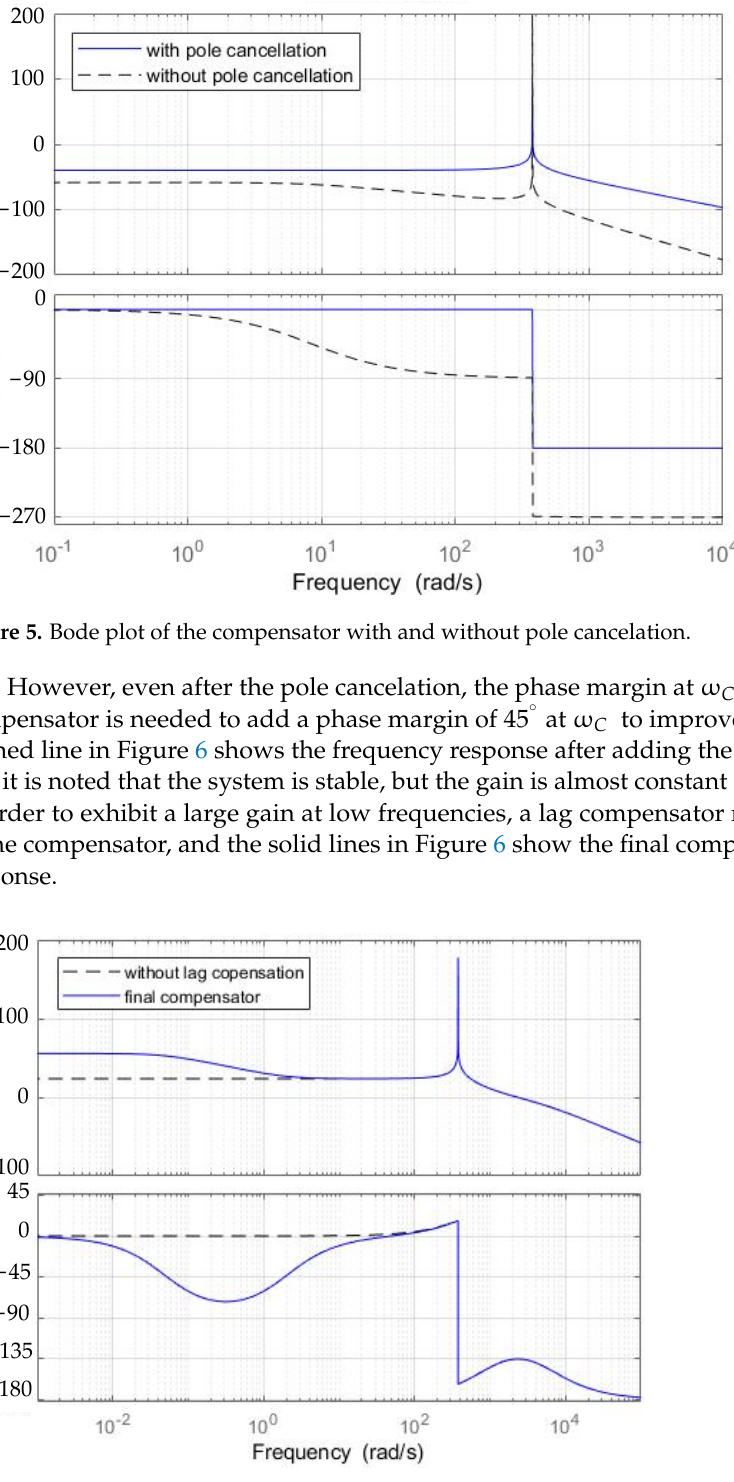
2.3.3. Synchronous Frame dq Controller [25] Equations (18)–(20) can be expressed in dq frame using the Park transformation as follows: